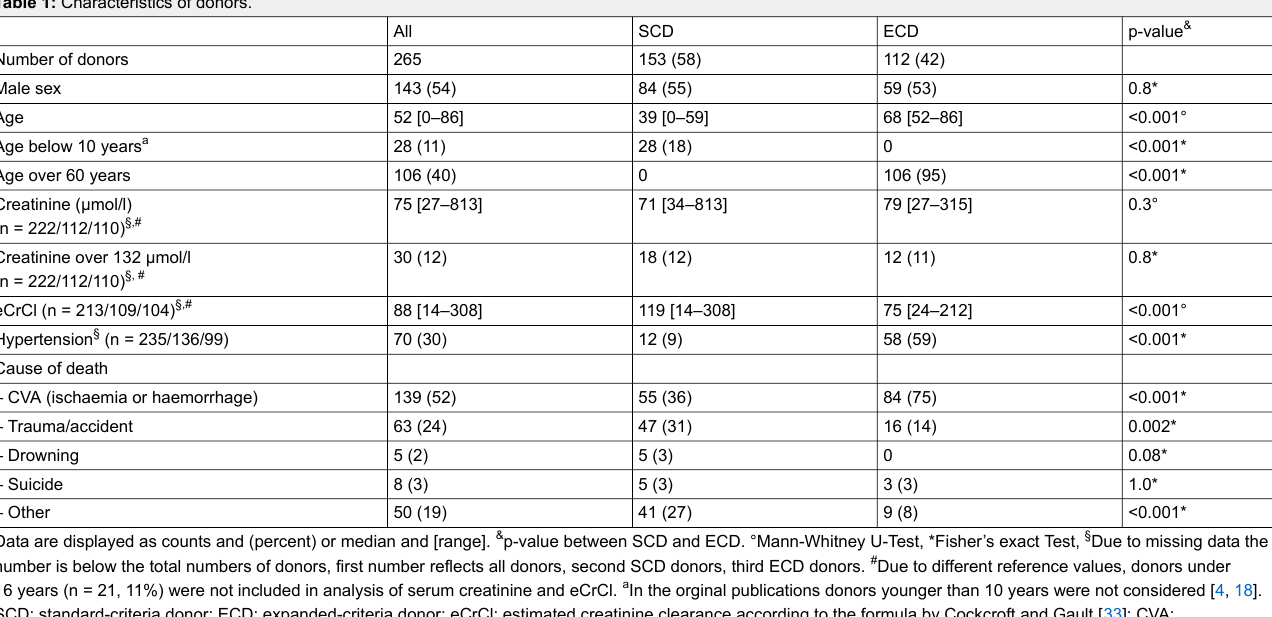
Table 1: Characteristics of donors.